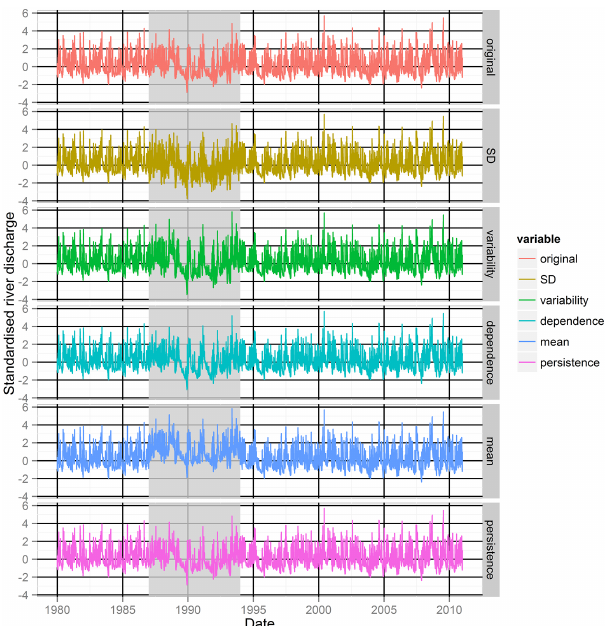
Figure 3. The time series resulting from the addition of artificial changes between 1987 and 1994 (shaded area) to normalised river flows for the South Tyne